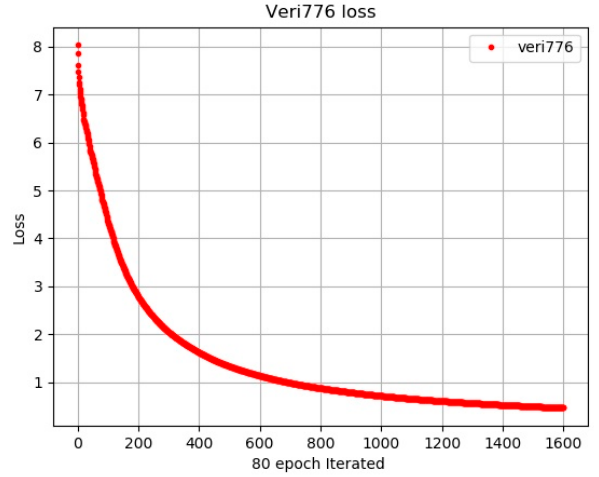
Figure 7. VeRi-776 loss curve.